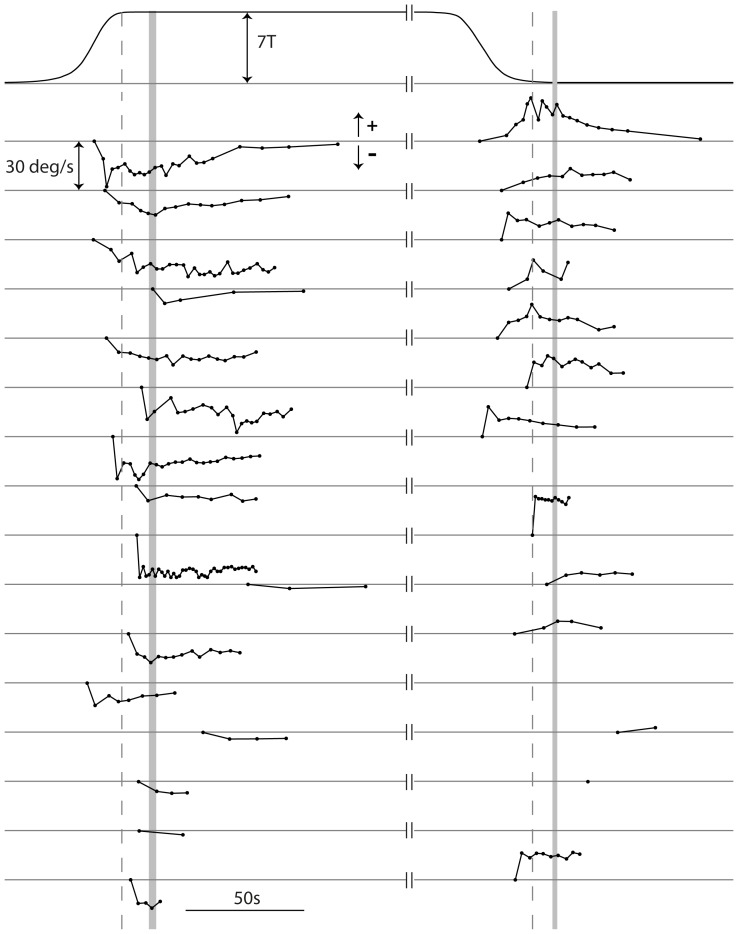
Perceived rotation velocity during long-duration exposures.Solid curve at the top shows group average (relative to alignment events) BZ magnitude experienced by the head. Traces below show perceived rotation velocities for participants who perceived horizontal plane rotation in experiment 2 (16 of 19). Each dot represents time of switch press. Perceived horizontal velocities (upward = positive X, downward = negative X) are plotted relative to individual zero base-lines. The first button press is set to 0 deg/s, although the perceived speed is indeterminate at that point. Individual perceived velocity plots are vertically offset and arranged from top to bottom in descending order of duration of in-phase button presses. Plots have been split horizontally with each part aligned to different events represented by vertical dashed lines (left: aligned to time head reaches 7T during in-phase; right: aligned to time head reaches 0.2T during out-phase). Vertical shaded segments represent 95% confidence interval of the end of bed movement time relative to the alignment events.